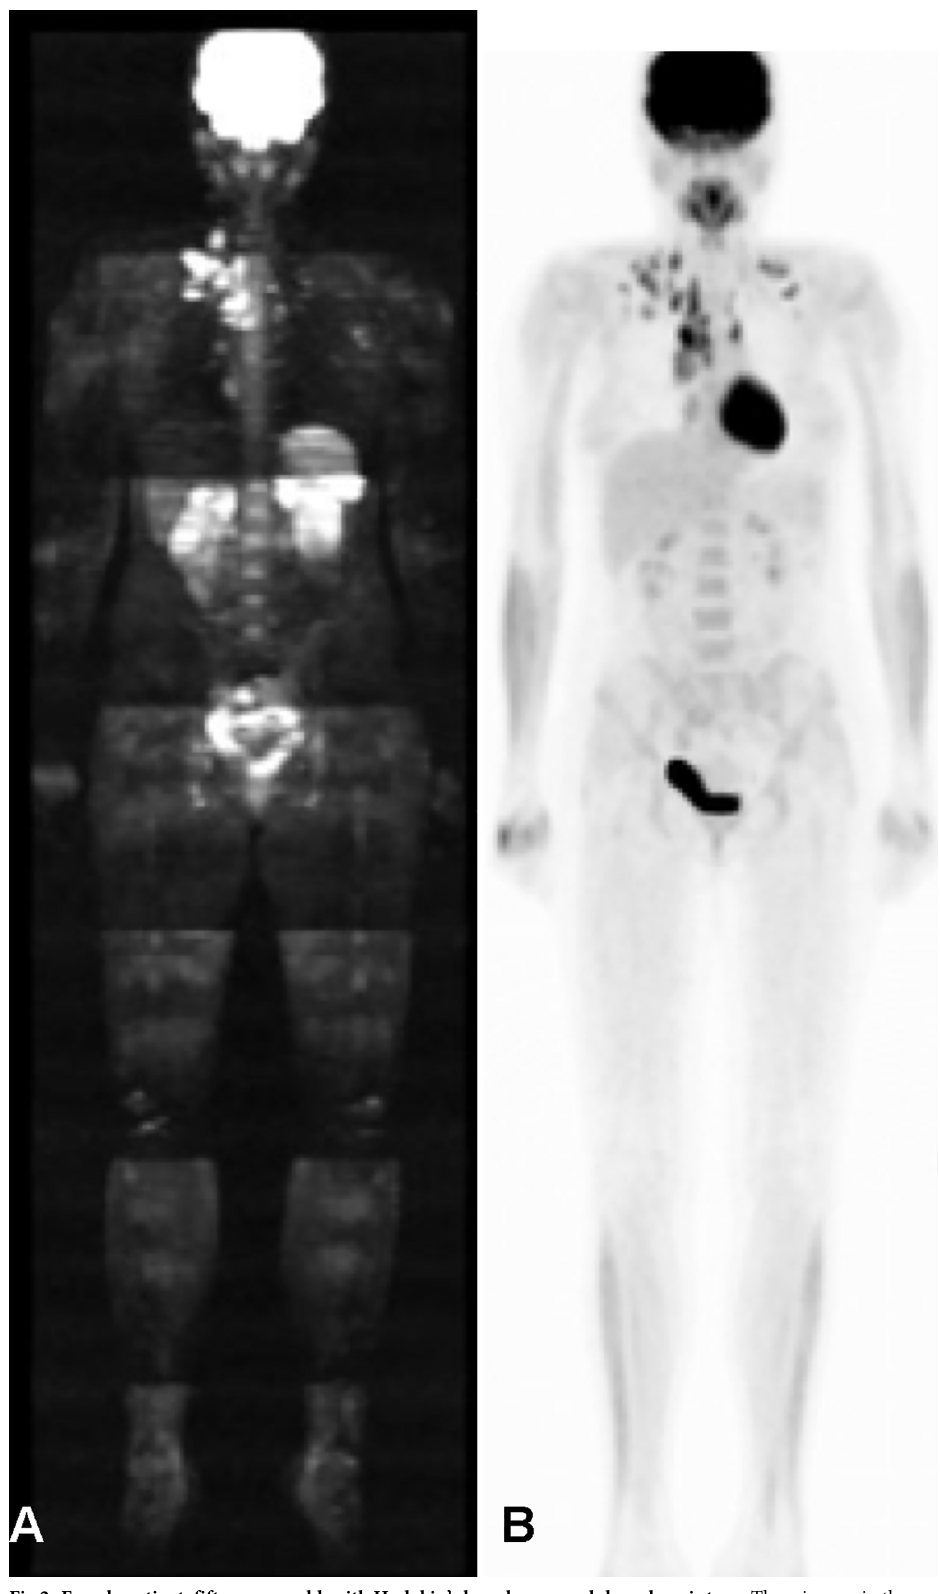
Fig 2. Female patient, fifteen-year-old, with Hodgkin’s lymphoma, nodular sclerosis type. These images in the coronal plane, (A) diffusion and (B) PET-CT, show mediastinal and supraclavicular lymph node enlargement. https://doi.org/10.1371/journal.pone.0238166.g002 PLOS ONE | https://doi.org/10.1371/journal.pone.0238166 August 27,